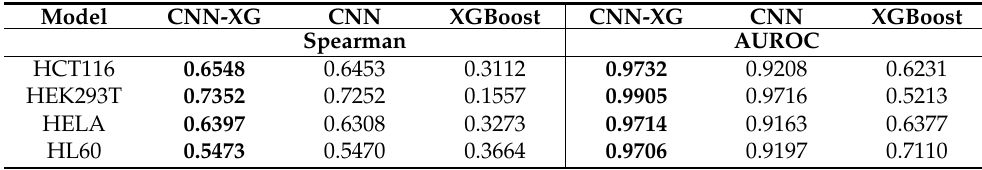
Table 1. Comparison with CNN and XGBoost. Model CNN-XG CNN XGBoost